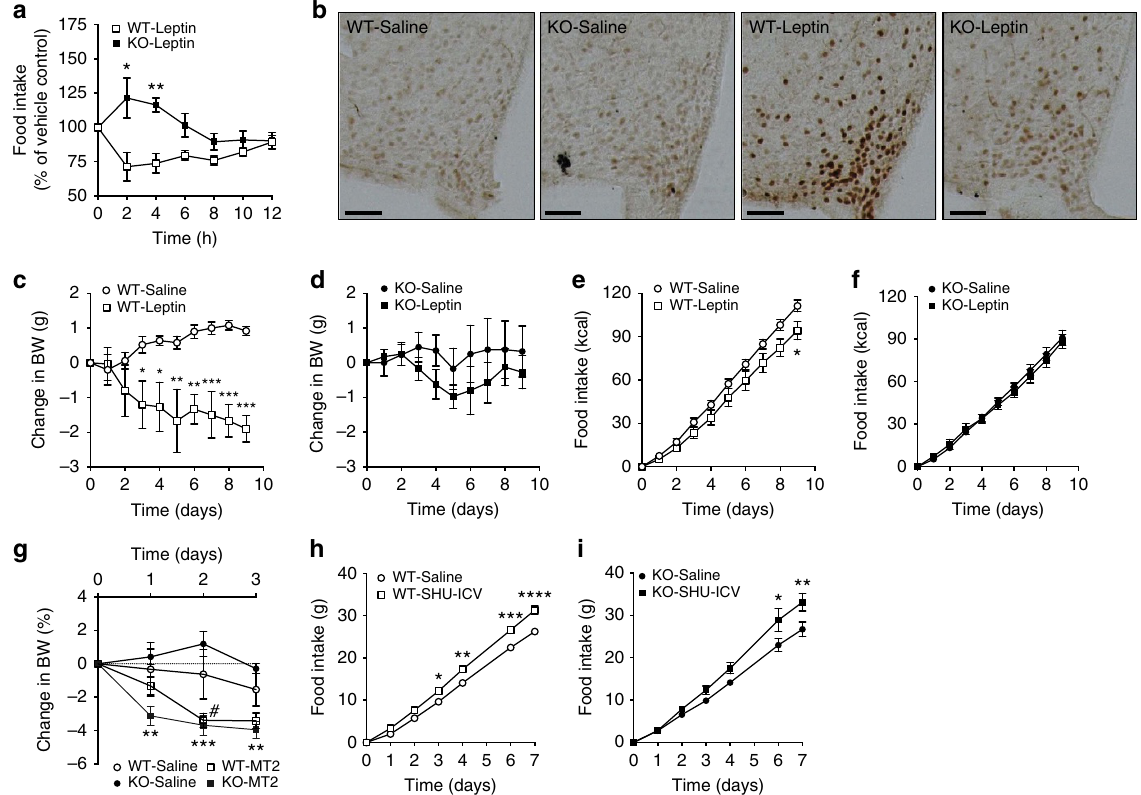
Figure 5 | Hypothalamic HDAC5 knockdown impedes leptin action: ( a ) Overnight food intake in chow-fed male HDAC5 WTand KO littermates ( n ¼ 8) subjected to a single intraperitoneal (i.p.) injection of vehicle saline or leptin (5mgkg (cid:2) 1 ) at the beginning of the dark cycle. ( b ) Representative immunohistochemical detection of STAT3 phosphorylation in hypothalamic slices of chow-fed male HDAC5 KO and WT littermates 30min after a single i.p. injection of vehicle saline or leptin (5mgkg (cid:2) 1 , n ¼ 3, Scale bar, 50 m m). ( c , d ) Body weight and ( e , f ) food intake in chow-fed male WTand HDAC5